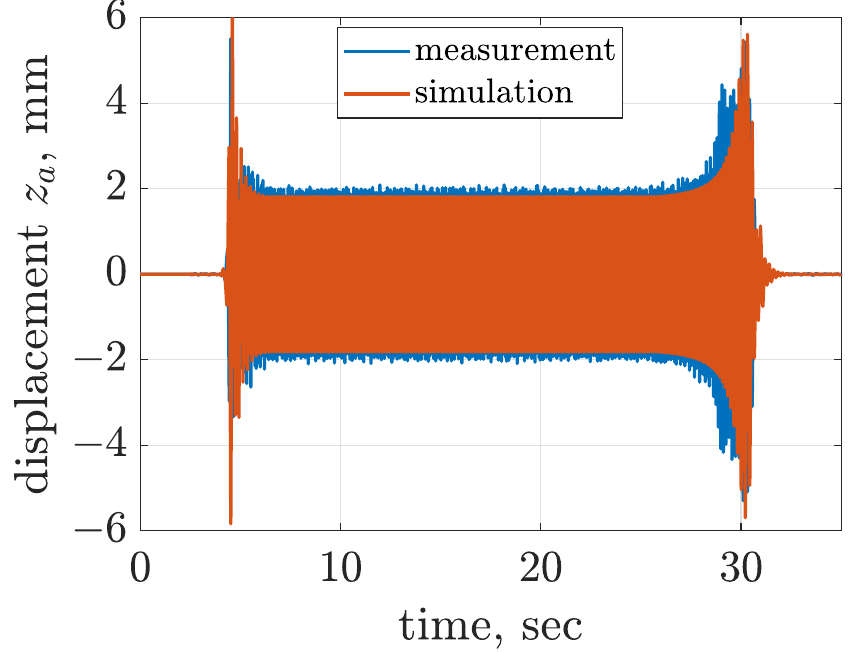
Figure 8. Comparison of time diagrams of vertical displacement z a corresponding to the averaged sensor location evaluated for measurement and simulation